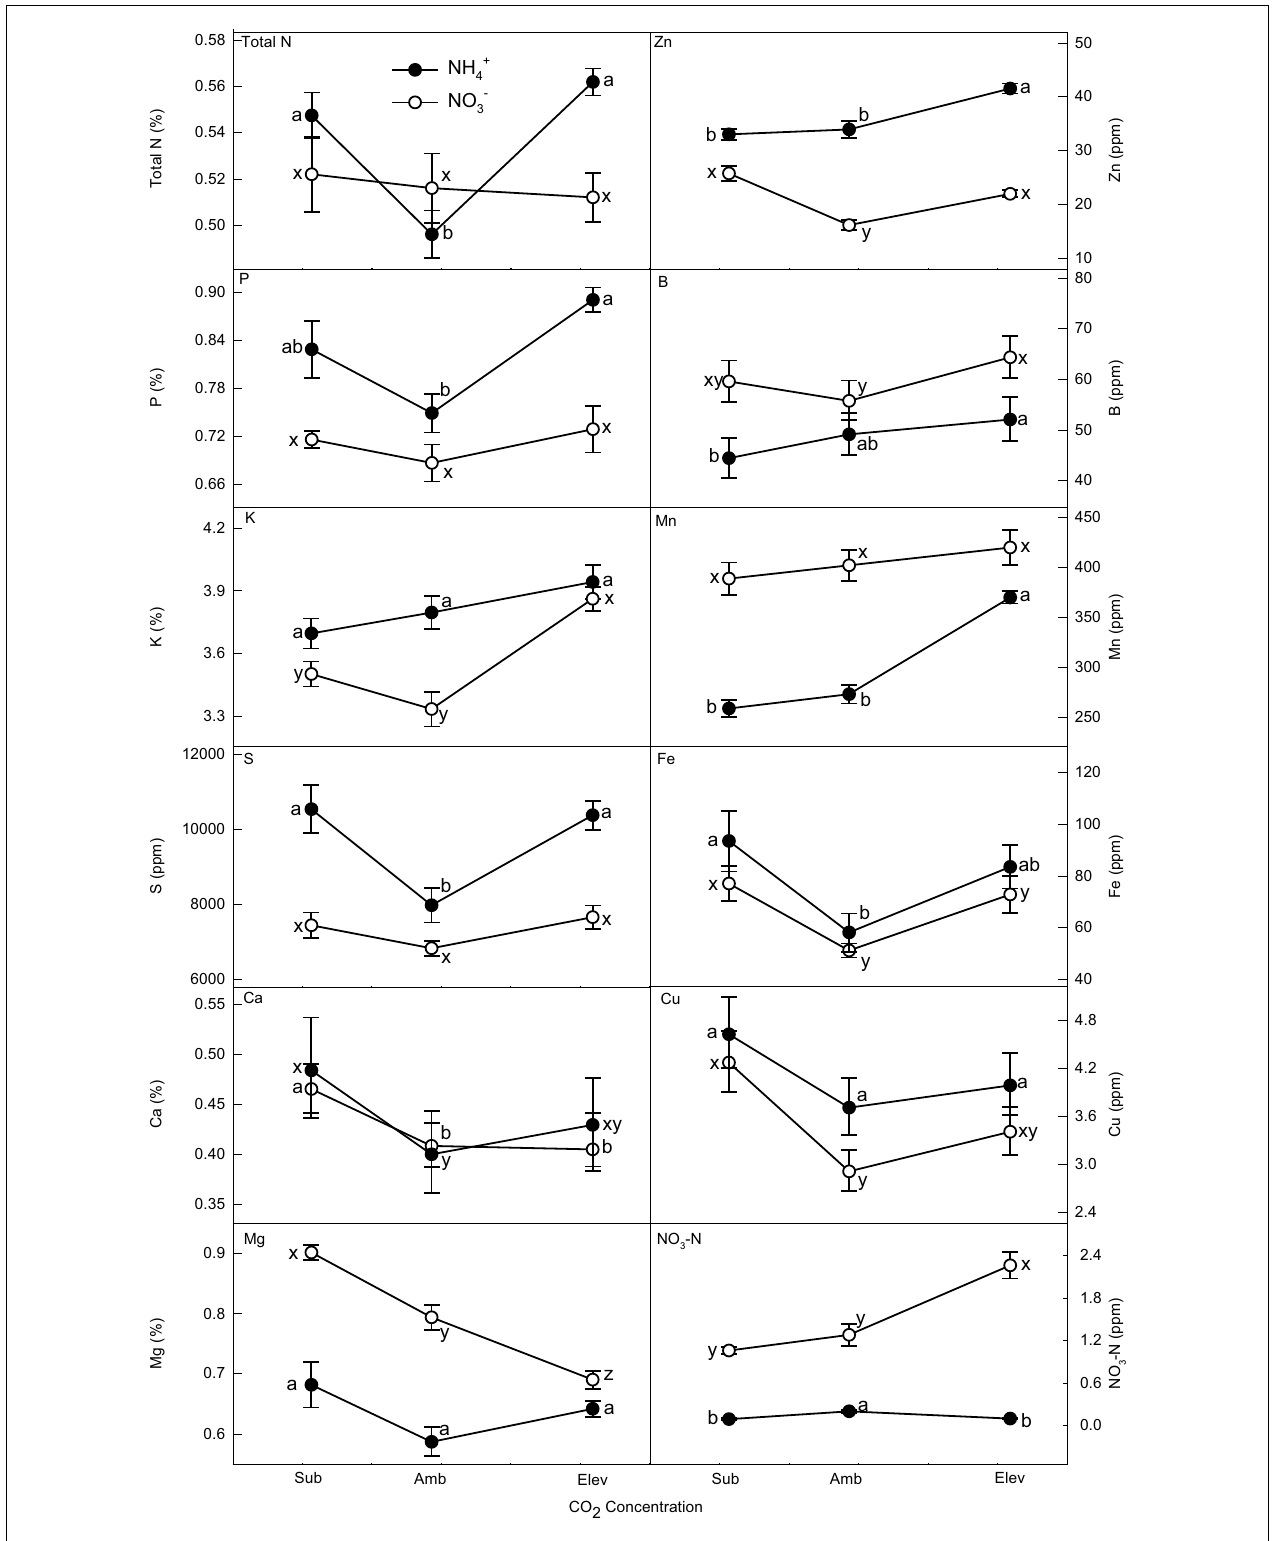
left of each frame. Differences are significant within N form if letters are different. Differences between N forms at each CO 2 concentration are generally significantly different if error bars do not overlap (see Table 1 for statistical